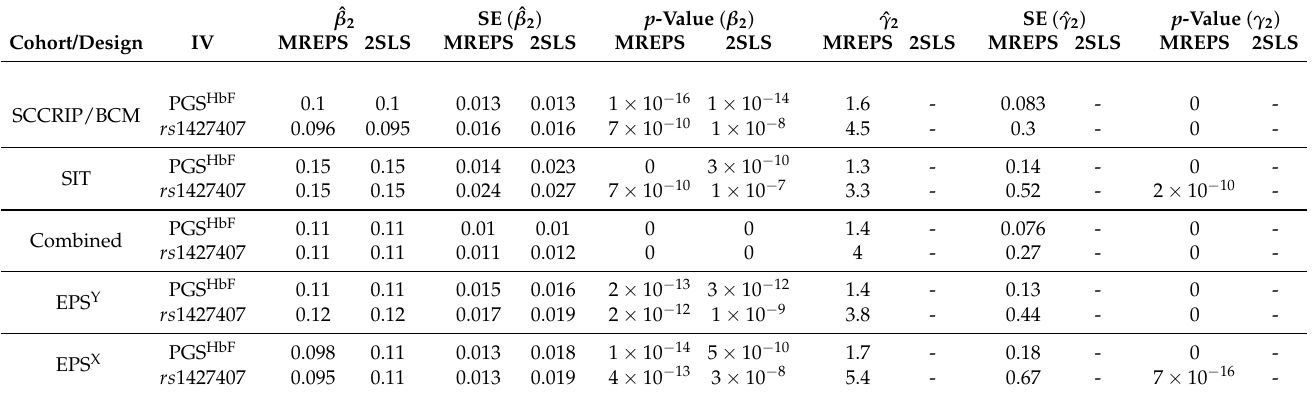
Table 2. MR analyses to assessing the causal effect of HbF on Hb of patients from the two cohorts of SCCRIP/BCM and SIT. Instrumental variables are PGS HbF and rs 1427407.